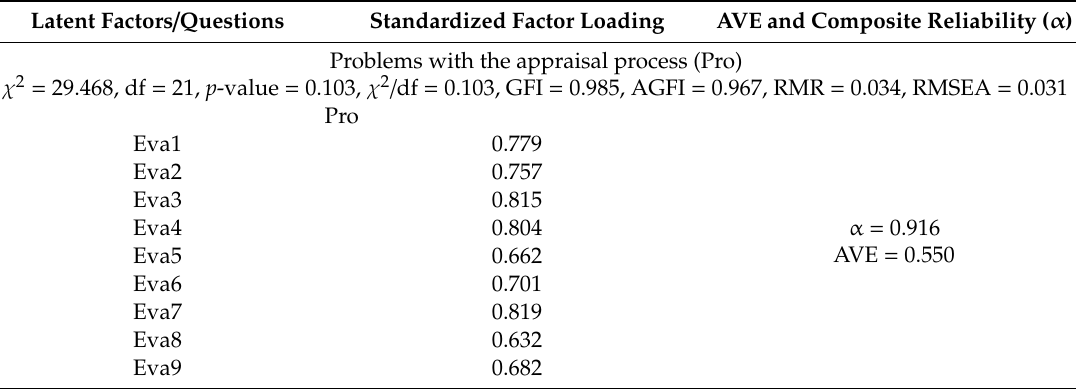
Table 1. Confirmatory factor analysis of latent factors in the tested